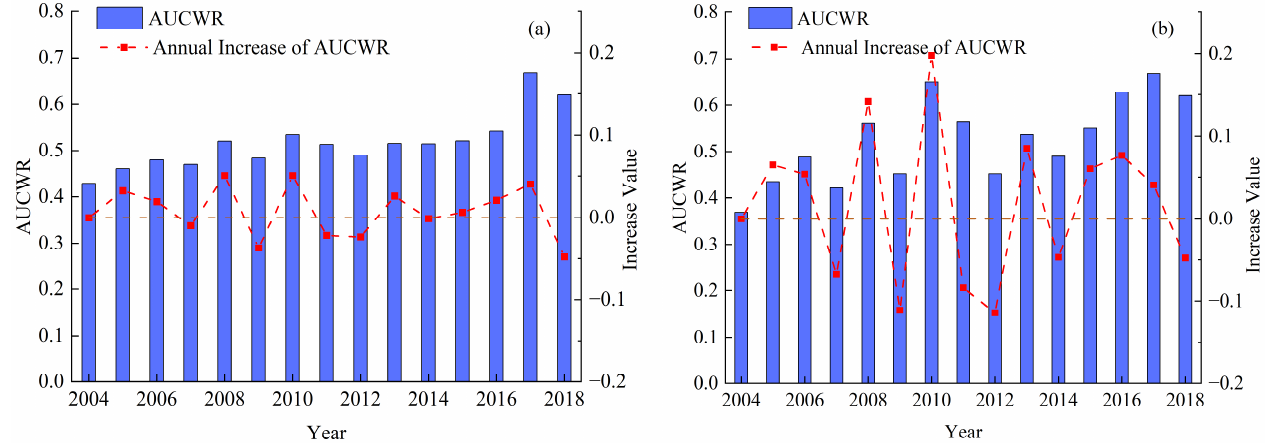
Figure 5. AUCWR and changes in the TRB. ( a ): calculation results of the harmony theory method. ( b ): calculation results of the comprehensive co-evolutionary model method.